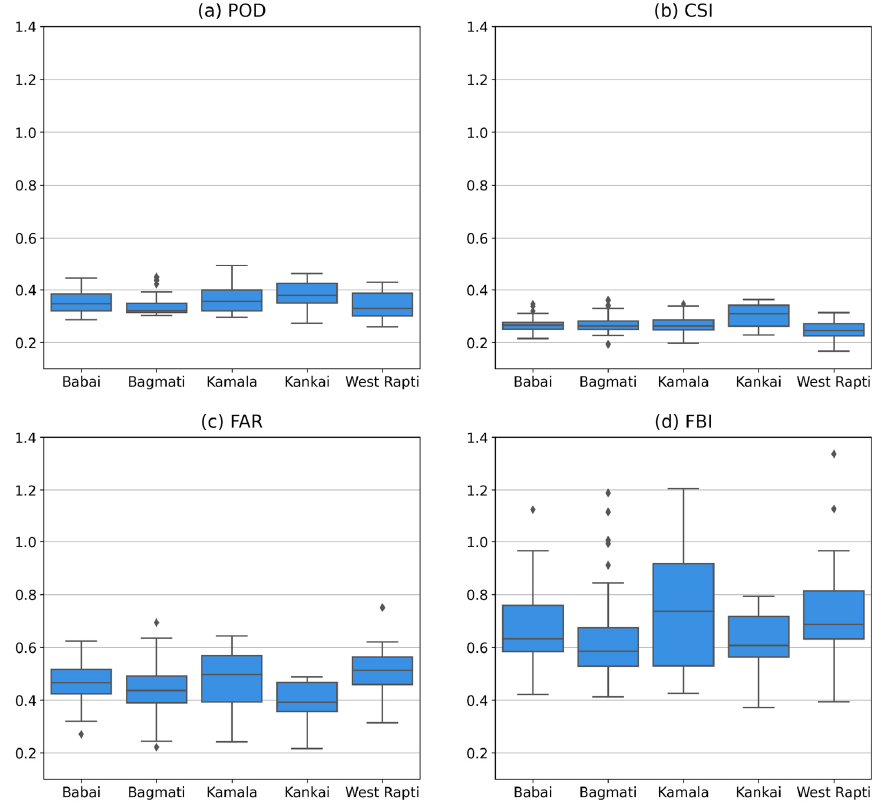
Figure 2. Performance of rainfall detection capacity of CHIRPS product with respect to rain gauge observations during 1986–2015 for all five basins, i.e., West Rapti (WR), Babai (BB), Bagmati (BM), Kankai (KK), and Kamala (KM).